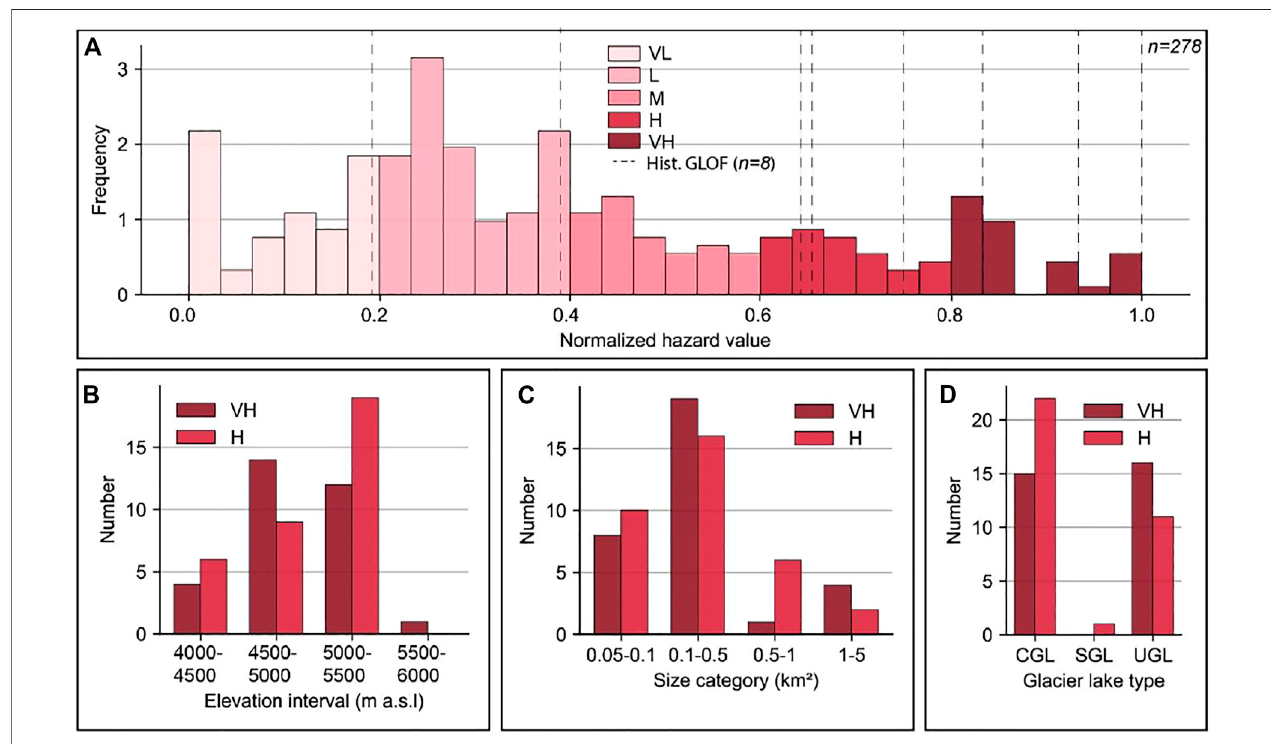
FIGURE 9 | The histogram (A) represents the GLOF hazard levels across all the glacial lakes (with area (cid:2) 0.05 km 2 and glacier-lake distance (cid:2) 1,000 m). The dashed lines show the hazard score for glacial lakes with a past GLOF history, which is also used to validate this study. The bars depict the distribution of high and very- high hazard level glacial lakes across the different elevation zones (B) , size categories (C) , and different lake types (D) .